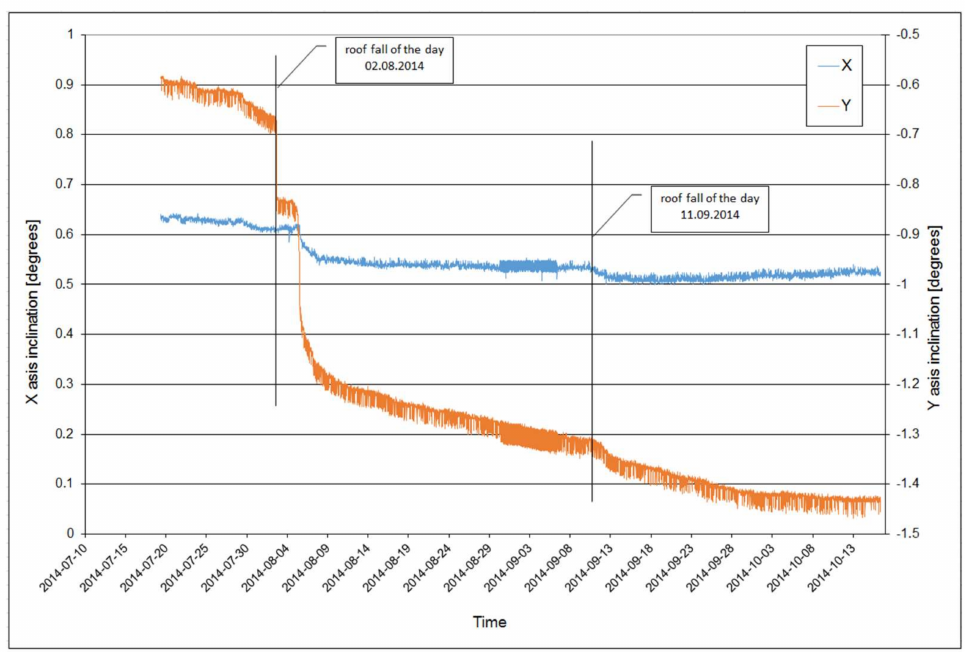
Figure 20. Changes in the inclination (X and Y components) recorded at station 1.1 located in the headgate.